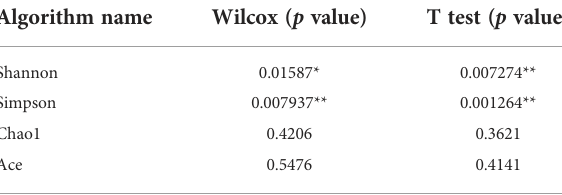
TABLE 1 Alpha diversity analysis of the cocultivated intestinal